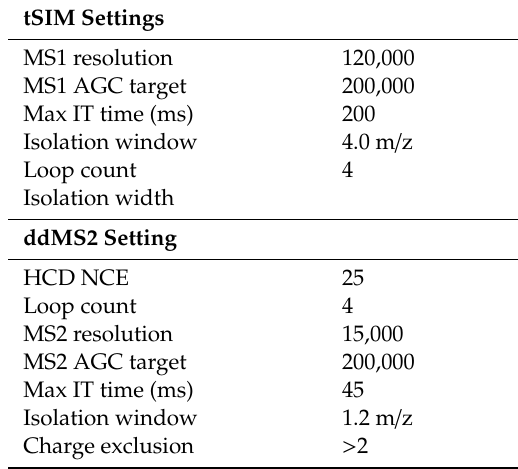
Table 1. Parameters on the QE HF Orbitrap utilizing the tSIM-ddMS2 methodology.